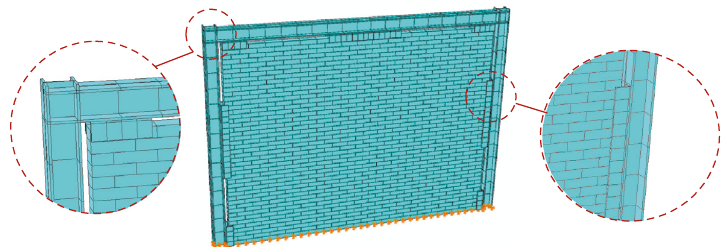
Figure 4: Finite element mesh and boundary conditions applied in the numerical model.